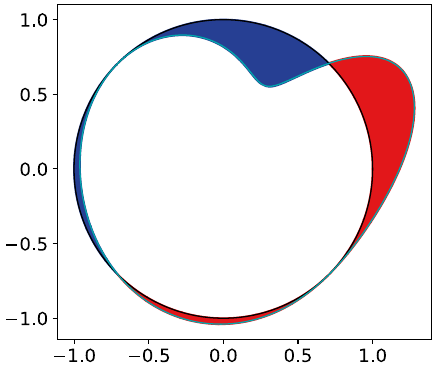
Fig. 4 Deformation of the Fermi contour in two dimensional momentum space 𝐩 ∕ 𝜋 for zero sound propagating along “cold spots” [21] diagonal 𝛽 = 𝜋 ∕ 4 in layered perovskites. For this special case of propagation along the nodal lines of the separable kernel of interaction, the electric charge, spin and current oscillations are zero. Moreover, we have a shear deformation of the Fermi surface in momentum